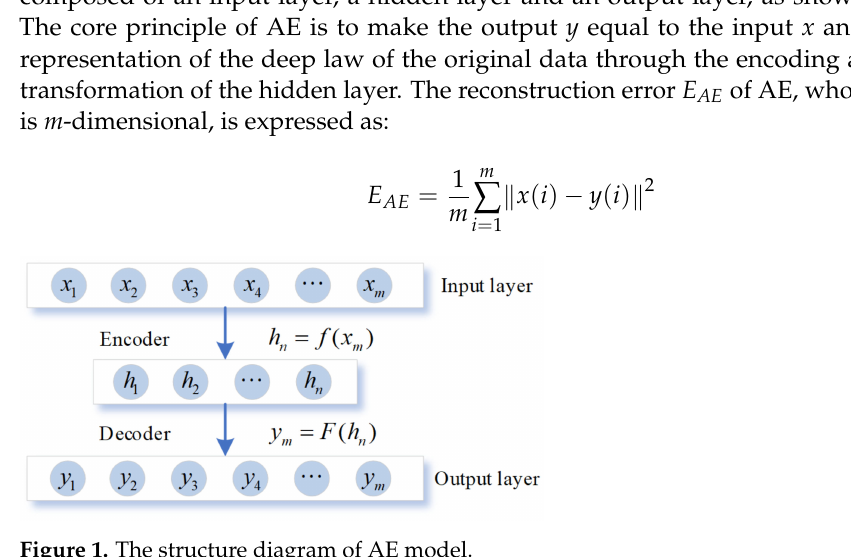
Figure 1. The structure diagram of AE